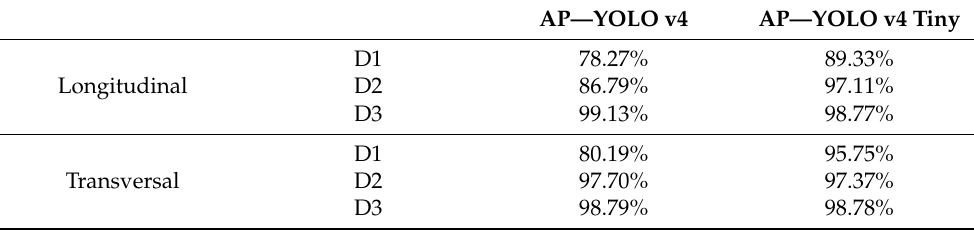
Table 3. Identification of long and short axis view (i.e., longitudinal and transversal to the IVC). AP—YOLO